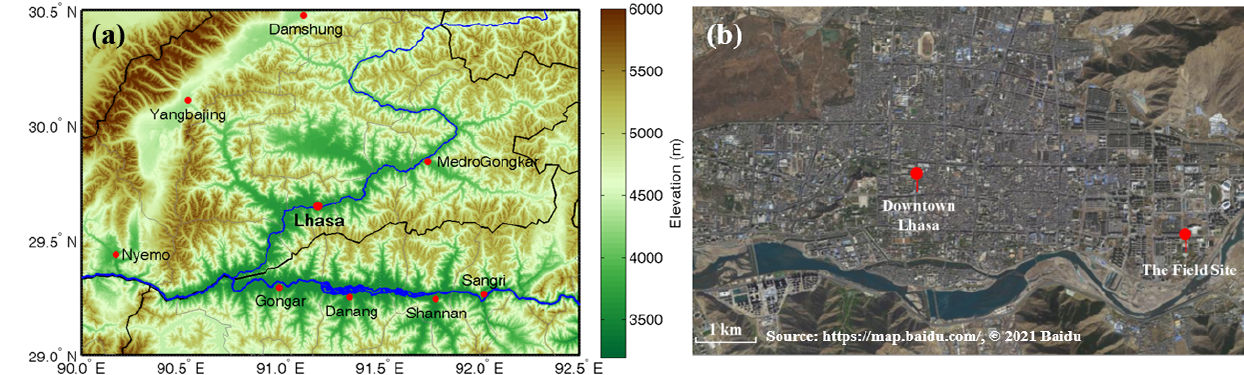
Figure 1. The topographic map of the Lhasa River valley (a) and the city map of Lhasa (b)